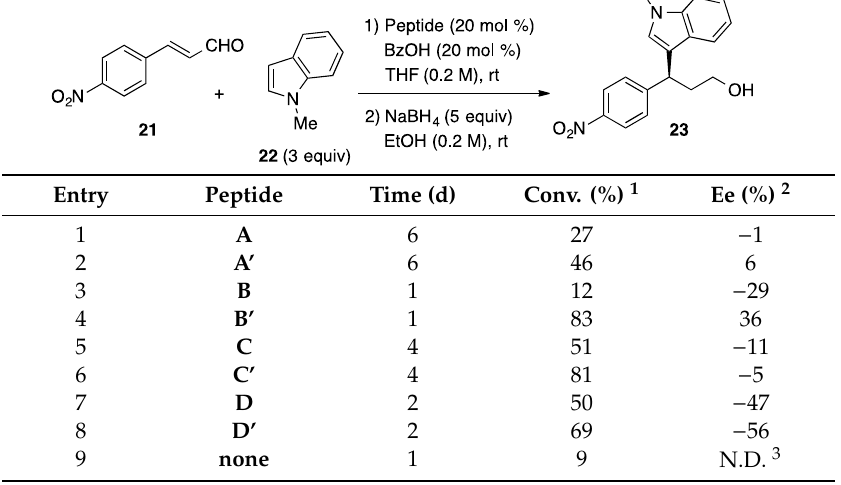
Table 1. Catalytic activities of unstapled peptides A – D and stapled peptides A’ – D’ in the Michael addition reaction of 21 and 22 .